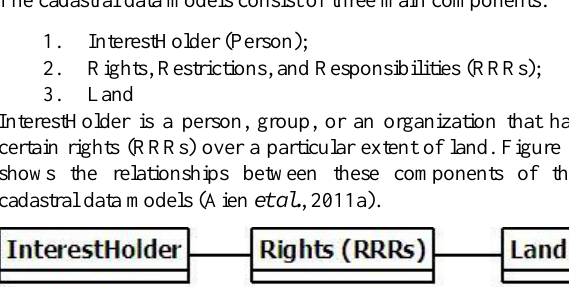
Figure 1. Cadastral Data Model (Oosterom et al., 2006)